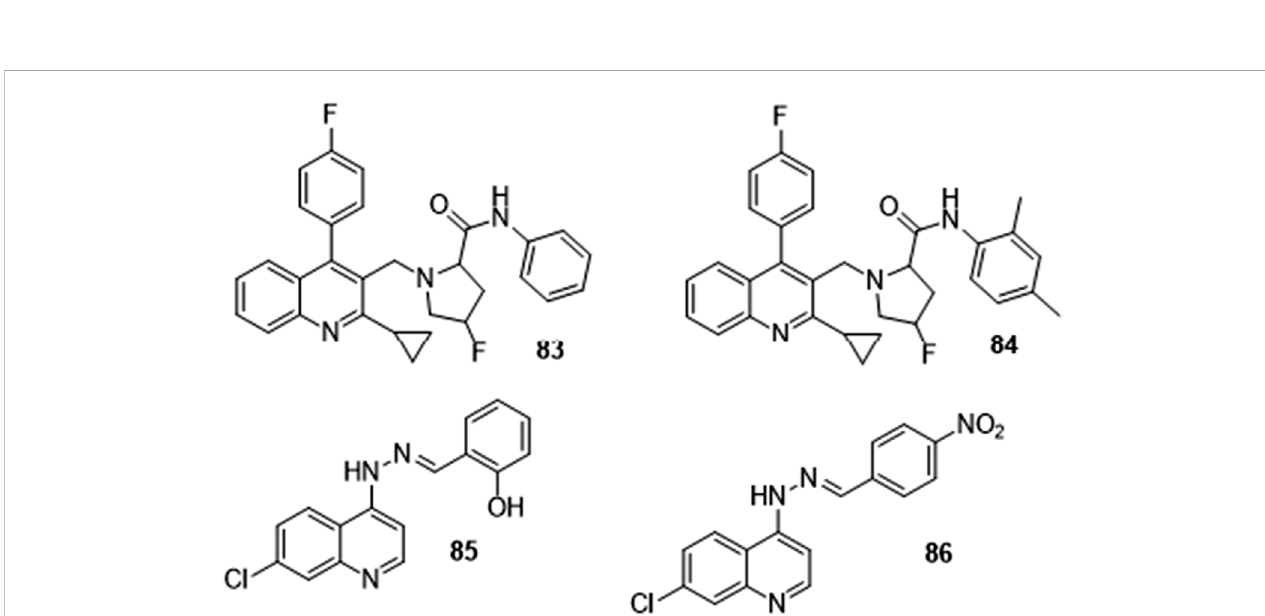
FIGURE 17 Quinoline- fl uoroproline amide and quinoline-imine hybrids with reported insilico ADMET.